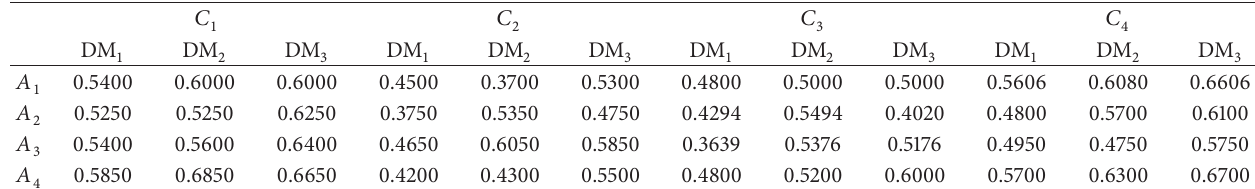
Table 7: The supports for each HFE from other HFEs.